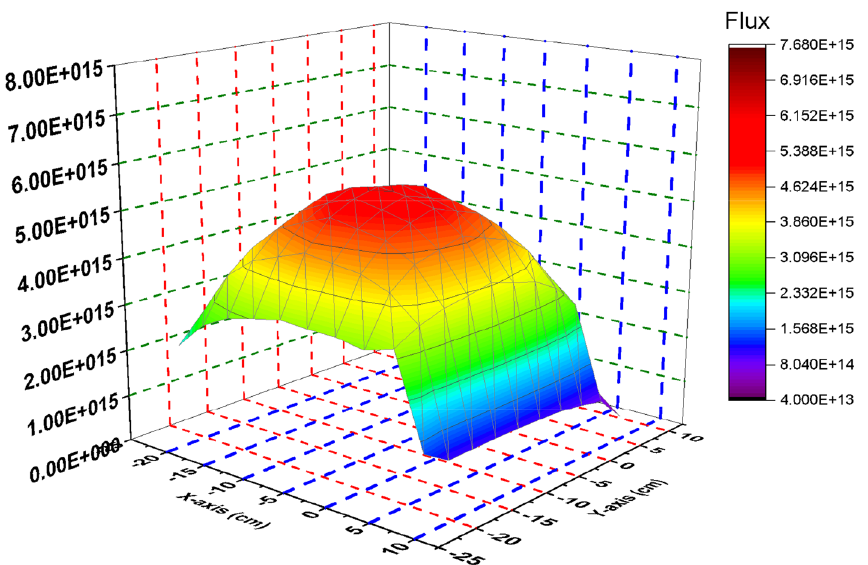
Figure 4. Epithermal Flux distribution for the four bundle using 10 meshes in case of B 4 C in the control blade